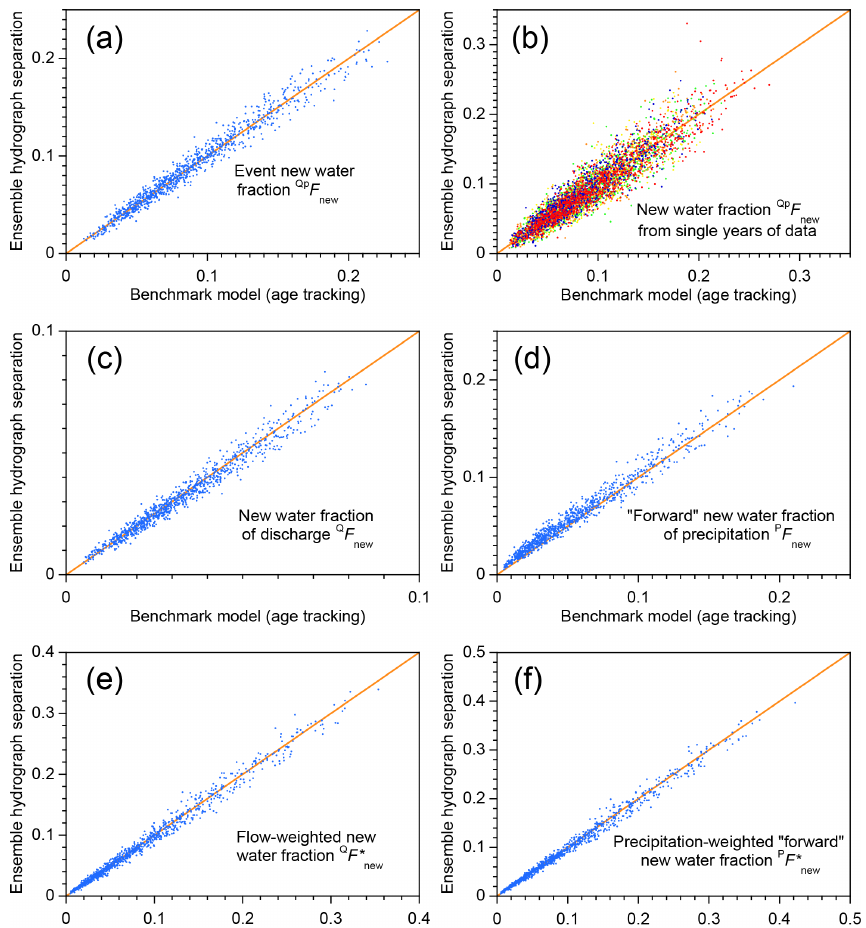
Figure 2. New water fractions predicted from tracer dynamics using ensemble hydrograph separation, compared to averages of time-varying new water fractions determined from age tracking in the benchmark model. Diagonal lines show perfect agreement. Each scatterplot shows 1000 points, each of which represents an individual catchment, with its own individual random set of model parameters (i.e., catchment characteristics), randomly generated precipitation tracer time series, and random set of measurement errors and missing values (see Sect. 3.1). The daily precipitation amounts are the same (Smith River time series; Mediterranean climate) in each case. The event new water fraction (a, b) is the average fraction of new (same-day) water in streamflow during time steps with precipitation, as described in Sect. 2.3. Panel (a) shows event new water fractions estimated from 5 years of simulated tracer data; panel (b) shows the same quantity estimated from single years (each year is denoted by a different color). Averaging over the 5 years reduces both the range and the scatter, compared to the single- year estimates. The new water fraction of discharge (c) is the fraction of same-day precipitation in streamflow, averaged over all time steps including rainless periods (Eq. 14, Sect. 2.4); its flow-weighted counterpart (e) is calculated using Eqs. (16)–(18) of Sect. 2.5. The forward new water fraction (the fraction of precipitation that becomes same-day streamflow; d ) is calculated using Eq. (21), and its precipitation- weighted counterpart (f) is calculated using Eq. (28). In all cases there is little evidence of bias, and the scatter around the 1 : 1 line is relatively